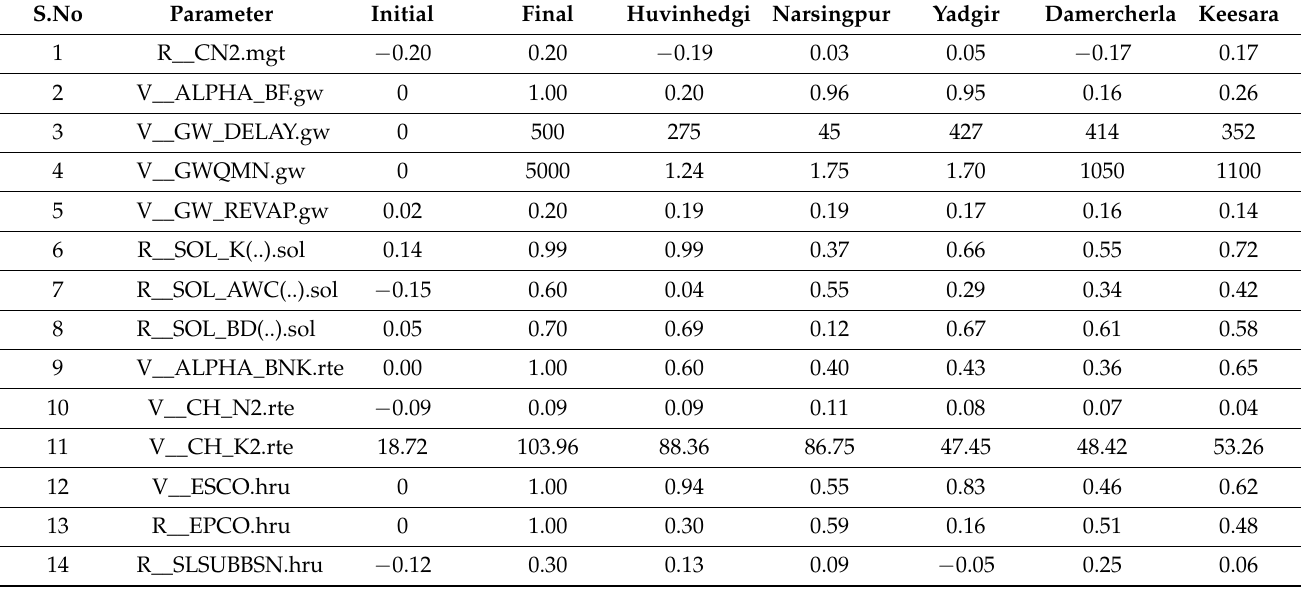
Table 3. Calibration parameter ranges for the five-gauge stations.